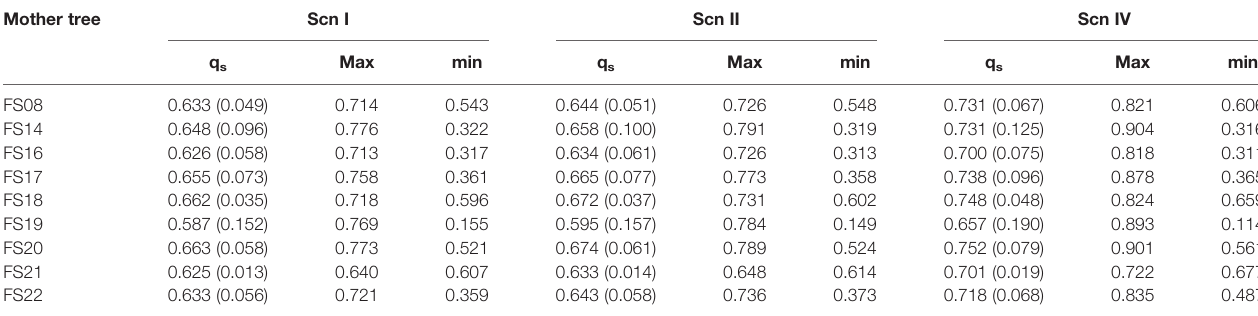
Mean, standard deviation (in brackets), maximum and minimum values per family are provided.